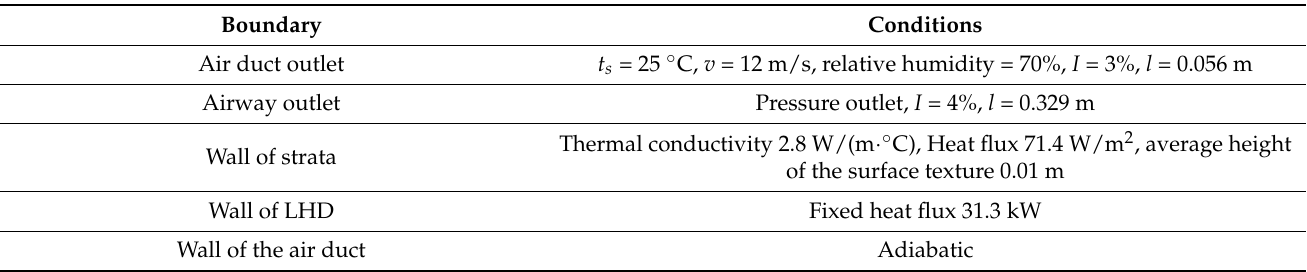
Table 4. Boundary conditions of CFD method.